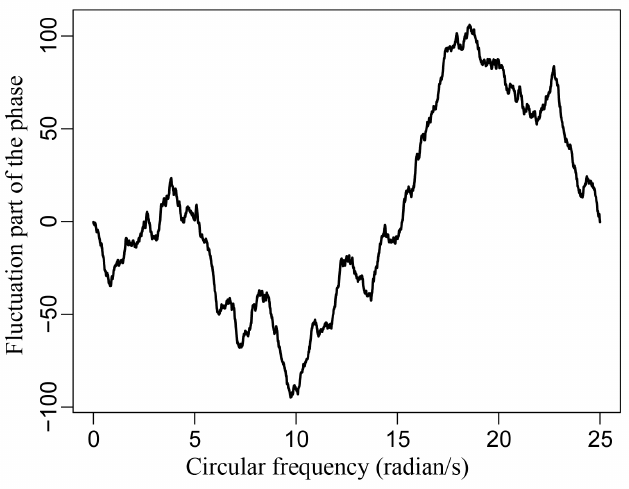
Figure 8. A Sample of the fluctuation part of the phase difference simulated by modified fBm